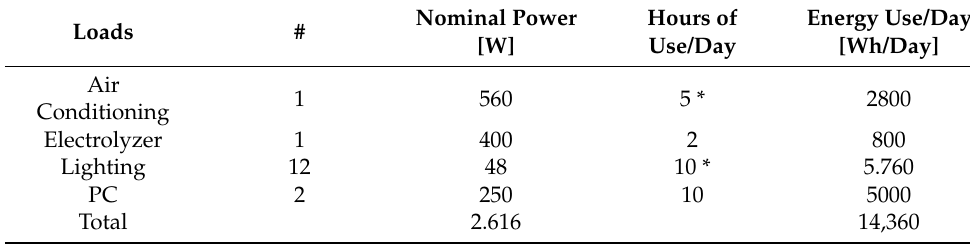
Table 4. The load profile of the